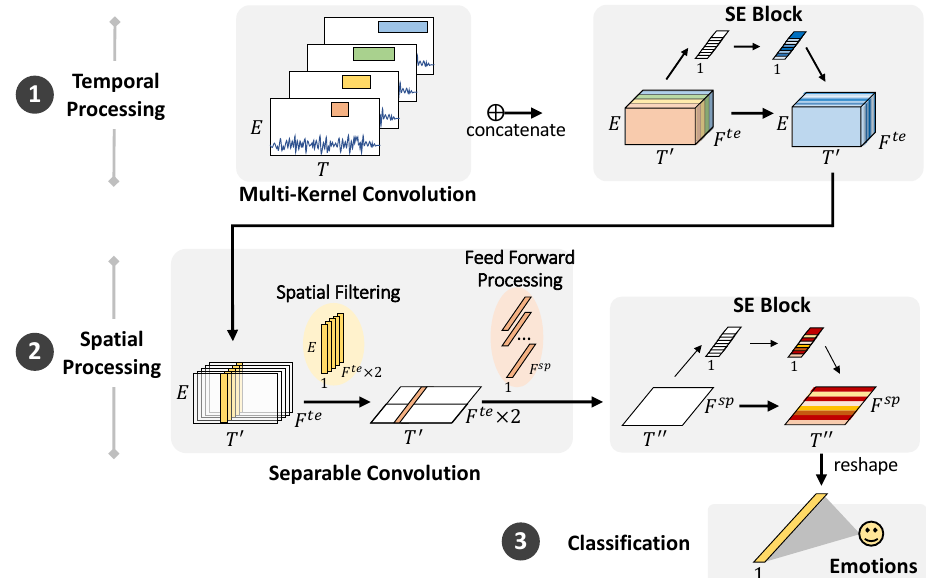
Figure 4. MultiT-S ConvNet architecture. The model comprises temporal filtering, spatial filtering, and classification layers. The first layer employs four types of temporal convolutions to learn multiple temporal features from raw EEG signals. Then, the separable convolution is used to learn temporal- specific spatial filters across electrode channels. The SE block is used to recalibrate the features of both filters. The final classification layer is used to discriminate the emotional